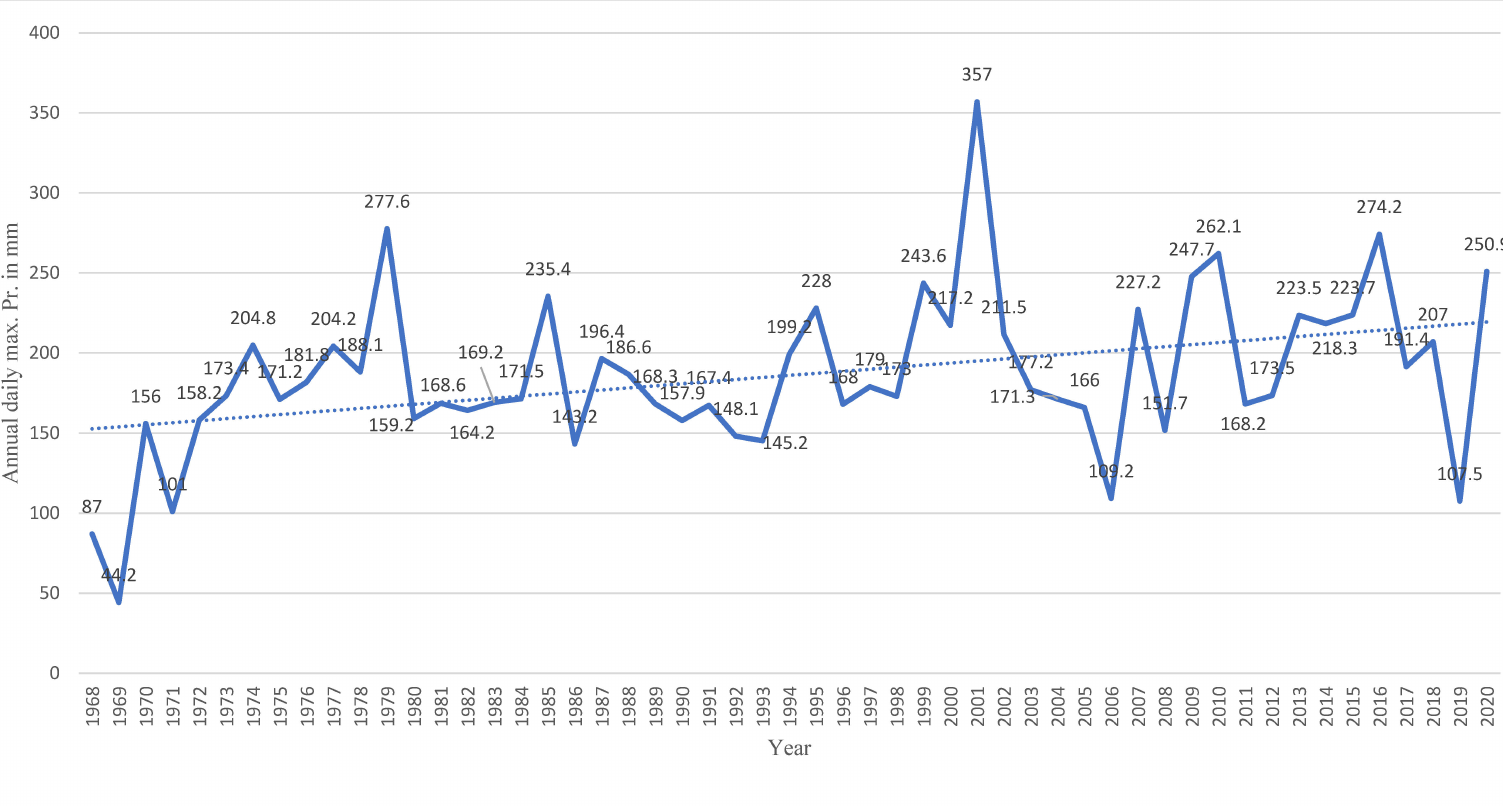
Figure A13. Observed annual daily maximum precipitation of Pokhara Airport,